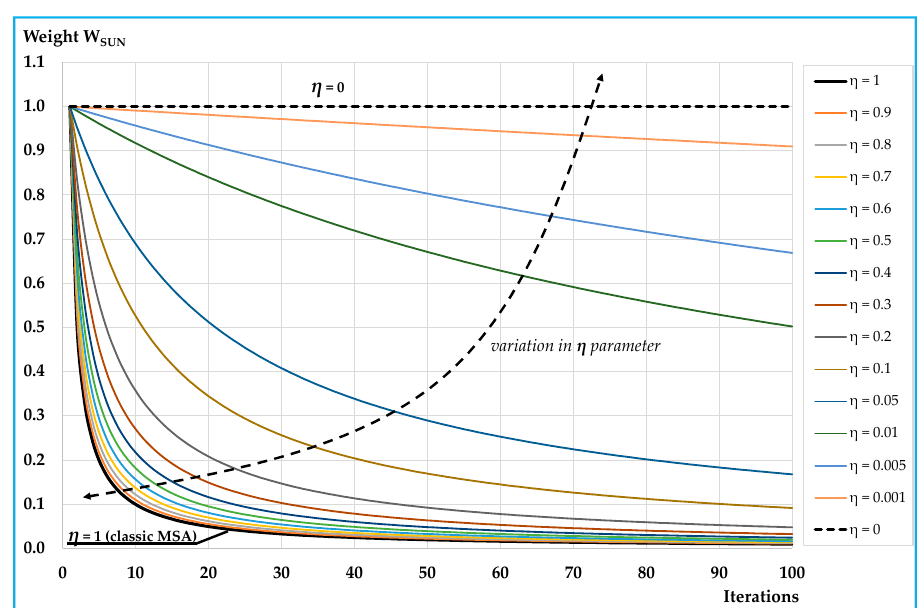
Figure 1. Values of weights w SUN .